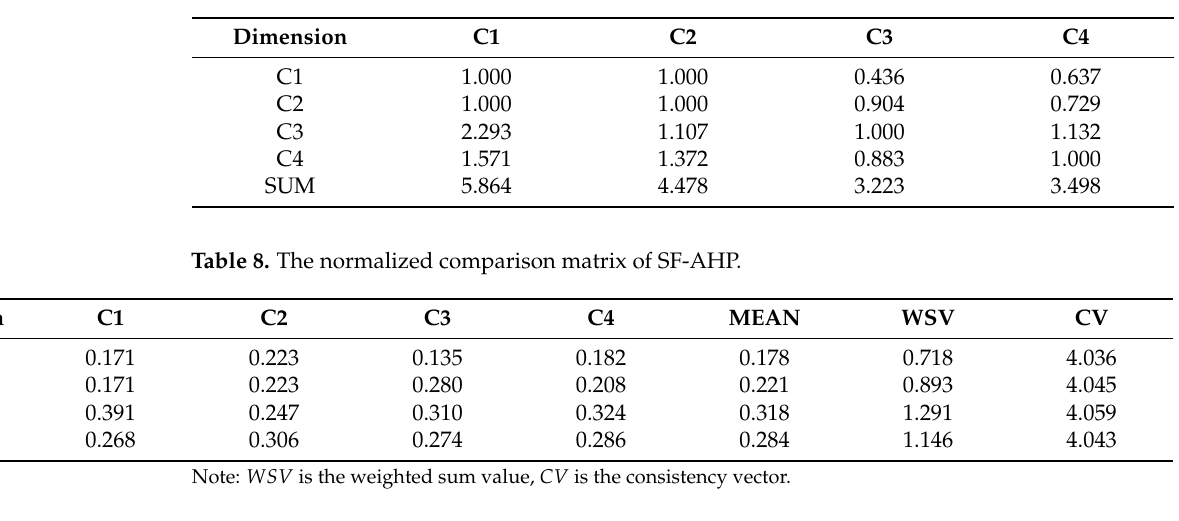
Table 7. The non-fuzzy comparison matrix of SF-AHP.